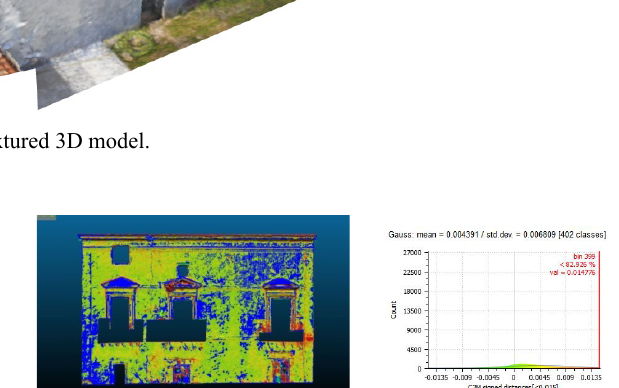
Figure 13. Comparison between the south-west photogrammetric mesh and TLS point cloud.